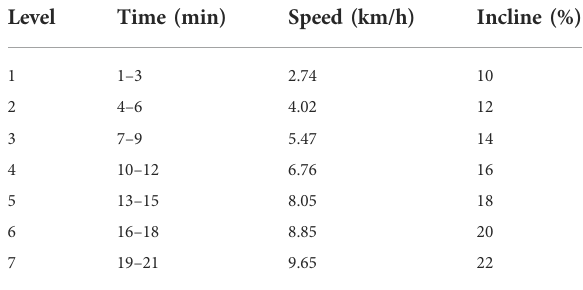
TABLE 2 The Bruce exercise